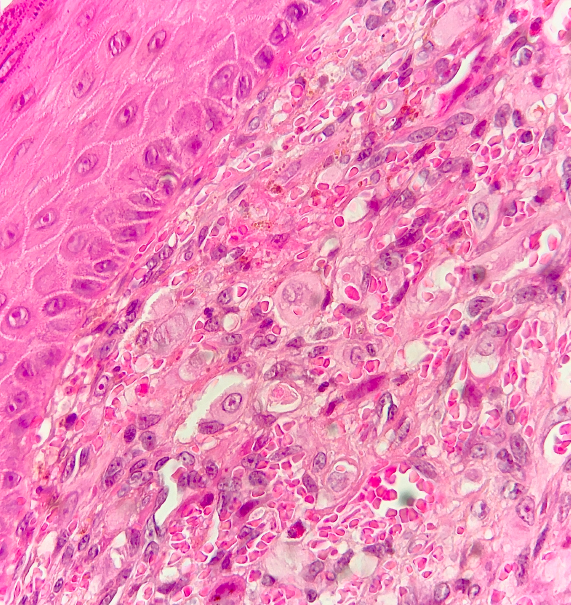
Figure 3. The lesion is composed of a proliferation of thick-walled blood capillary vessels containing large endothelial cells with ample, eosinophilic, glassy cytoplasm (haematoxylin–eosin–saffron stain).